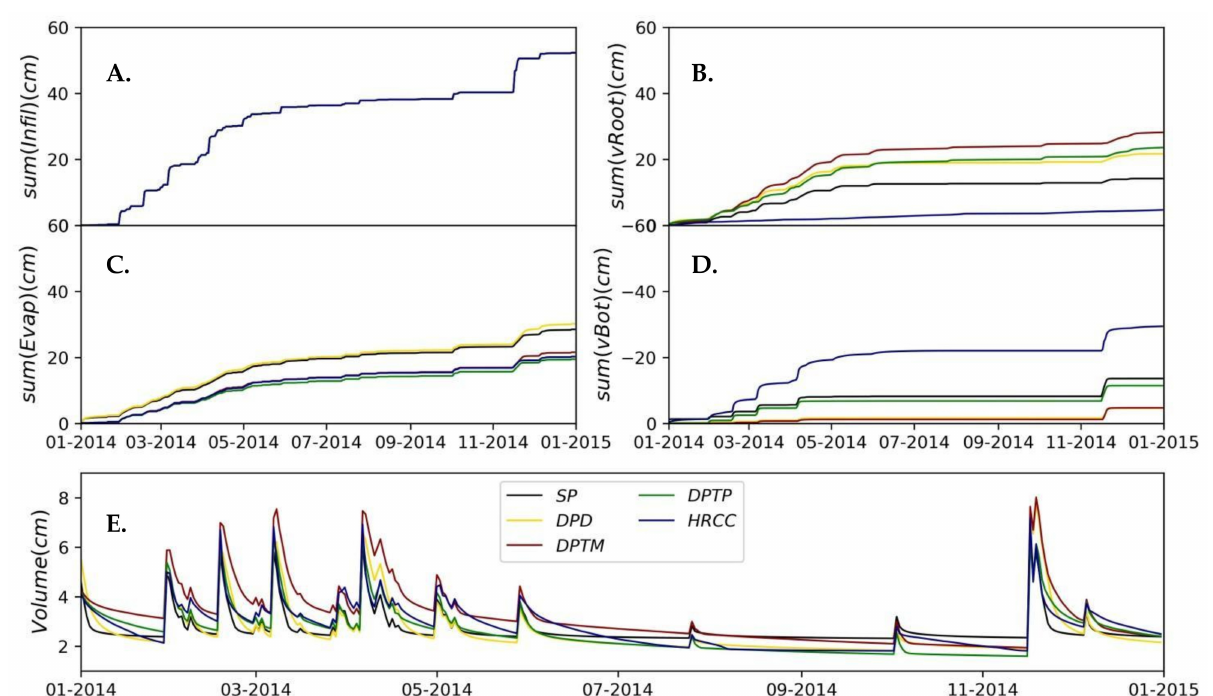
Figure 9. Cumulative flows in 2014 for the BR-GST tower with the SP, DPD, DPTM, DPTP, and HRCC models. Where ( A ). sum(Infil)—accumulated infiltration; ( B ). sum(vRoot)—accumulated root water uptake; ( C ). sum(Evap)—accumulated evaporation; ( D ). sum(vBot)—accumulated bottom discharge; ( E ). Volume—soil water